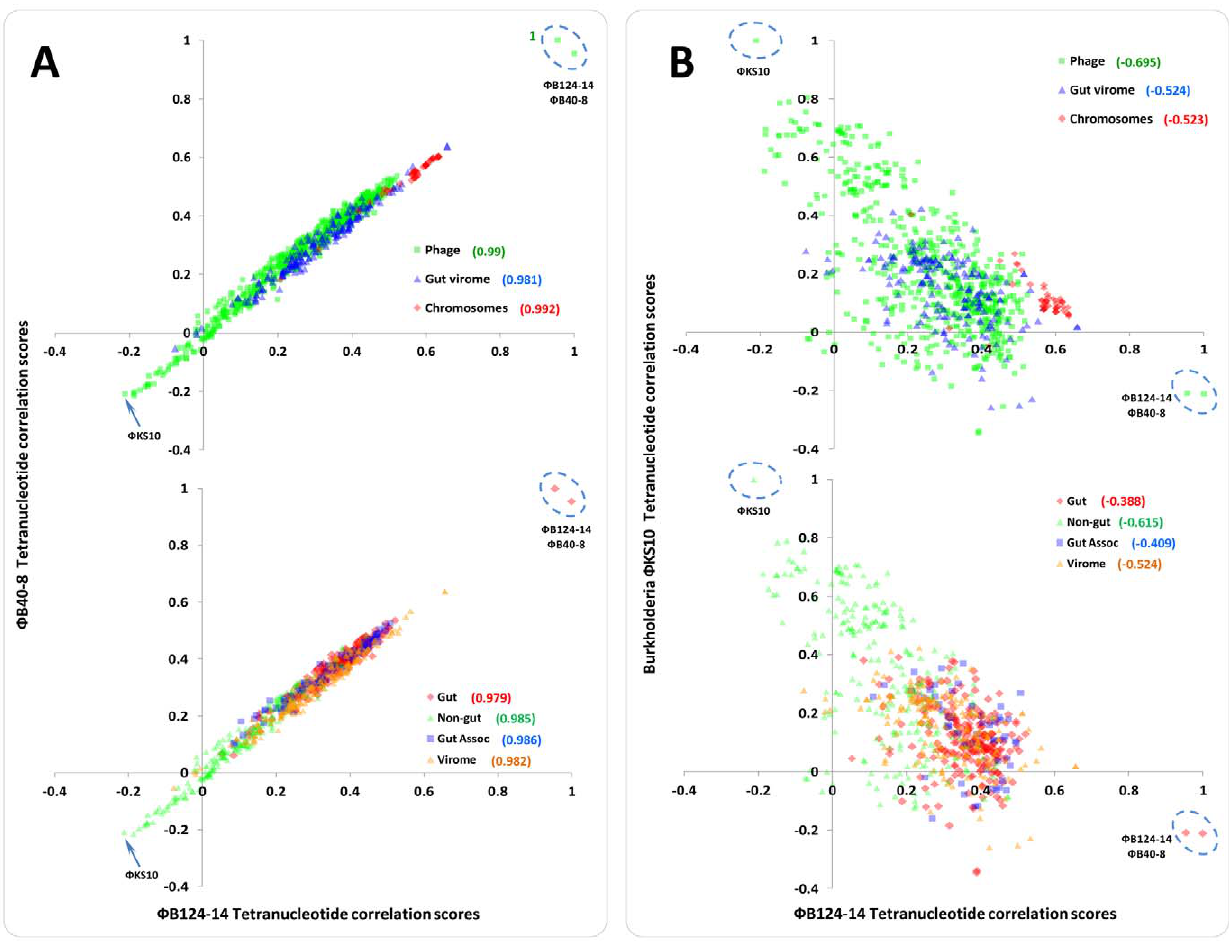
Figure 8. Comparison of tetranucleotide repeat frequency patterns in bacteriophage genomes and ecological profiling of w B124-14 and w B40-8. The tetranucleotide repeat frequency (TRF) correlation scores for w B124-14, w B40-8 and Burkholderia w KS10, were compared using scatter plots and correlation of data examined using the Pearson coefficient. A complete list of genomes and sequences utilised in this analysis is provided in Table S3. A. Comparison of TRF scores for w B124-14 (x-axis) vs w B40-8 (y-axis). B. Comparison of TRF scores for w B124-14 (x-axis) vs Burkholderia w KS10 (y-axis). A, B. Upper charts plot scores for all phage genomes, viral metagenome fragments, and Bacteroides genomes. Phage = TRF scores from comparisons to 611 phage and prophage genomes. Virome = TRF scores from comparisons to 188 large fragments ( . 10 Kb) from human gut viral metagenomes [6]. Chromosome = TRF scores from comparison to 48 Bacteroides spp . genome sequences. Each sequence type is represented by a different colour and symbol as indicated in the figure legends on each chart. The intensity of shading of data points reflects the number of data points represented in a given area with a greater intensity indicating more overlapping data points. Values in parentheses provide Pearson correlation scores for each sequence type. Lower charts plot TRF scores for sequences assigned to one of three categories based on their relation to the human gut microbiome: Gut = comprises bacteriophage infecting bacterial genera commonly forming part of the normal human gut microbiota. Gut Associated = comprises bacteriophage genomes infecting bacterial genera whose member species are associated with the gut but not generally considered to be members of the normal gut microbiota (such as primary invasive gut pathogens), or where member species are more commonly associated with environmental habitats. Non-Gut = contains bacteriophage infecting bacterial genera with member species not considered to be part of the human gut microbiota or typically associated with this community, and primarily encompasses bacteriophage infecting genera of environmental origin. Virome = All large fragments (n=188, . 10 Kb) assembled using CAMERA workflows (per individual) from human gut viral metagenomic libraries [6,91]. Each sequence category is represented by a different colour and symbol as indicated in the figure legends on each chart. For the purposes of this analysis phage infecting a particular host bacterial genus were only utilised if four or more representative phage genomes were available (540 complete phage genomes, representing 31 bacterial genera). The intensity of shading of data points reflects the number of data points represented in a given area with a greater intensity indicating more overlapping data points. Values in parentheses provide Pearson correlation scores for each sequence type.